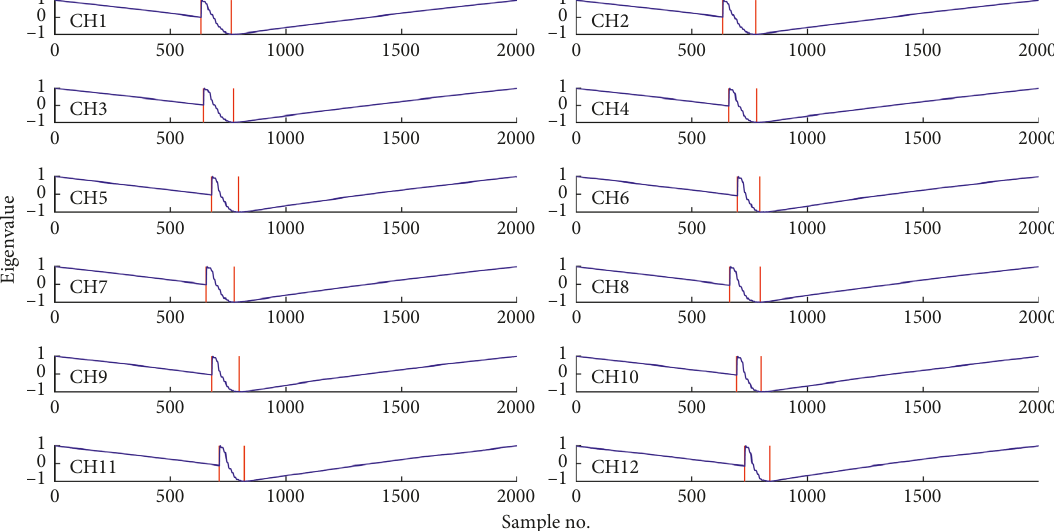
Figure 5: Eigenvalues (onset time and end time) of receiving record.